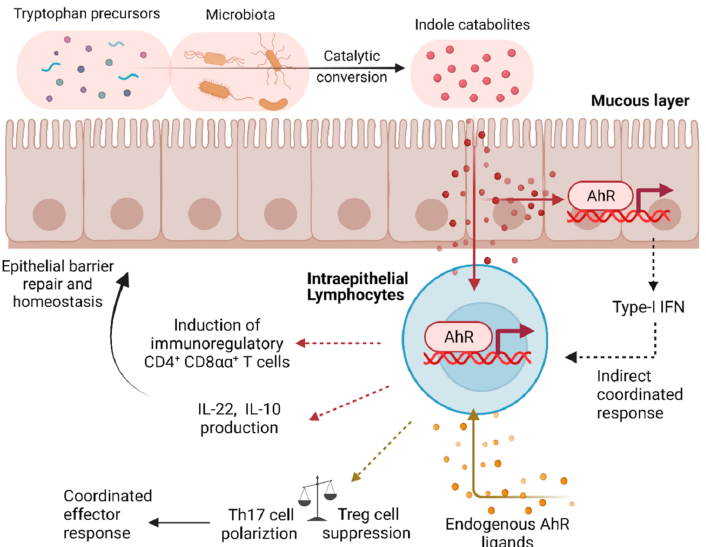
Figure 2. The aryl hydrocarbon receptor (AhR) is a QS-like regulator in immune cells. AhR expressed by immune cells (e.g., intraepithelial T cells) and non-immune cells (e.g., epithelial cells) senses exogenous and endogenous ligands, such as tryptophan metabolites produced by gut microbiota and orchestrates host transcriptional changes resulting in cytokine production and re-programming of T cells in response to environmental changes and altered metabolic